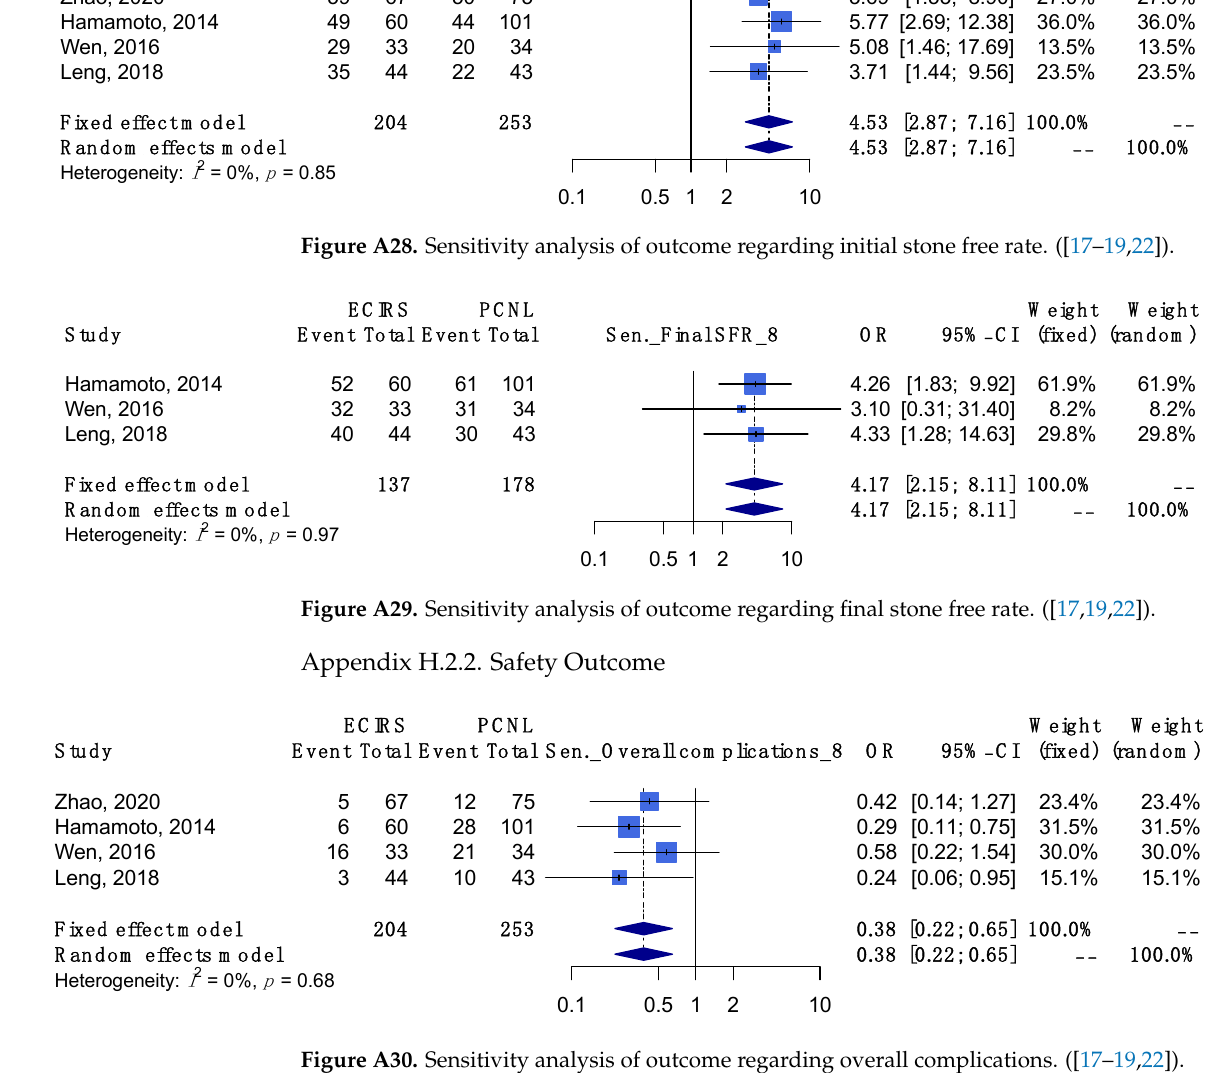
Figure A30. Sensitivity analysis of outcome regarding overall complications.